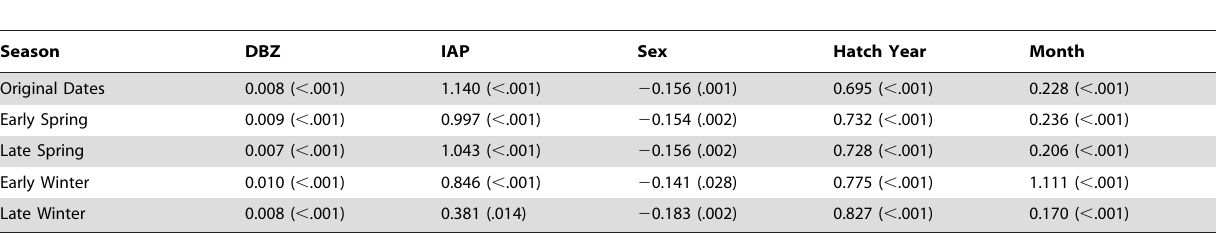
Table 4. Maximum Likelihood estimates (p-values) for key model parameters when AIV data are restructured such that the timing of breeding (April 1 to September 30) and overwintering (October 1 to March 31) seasons differs from that used to generate the parameter estimates shown in Table 3.